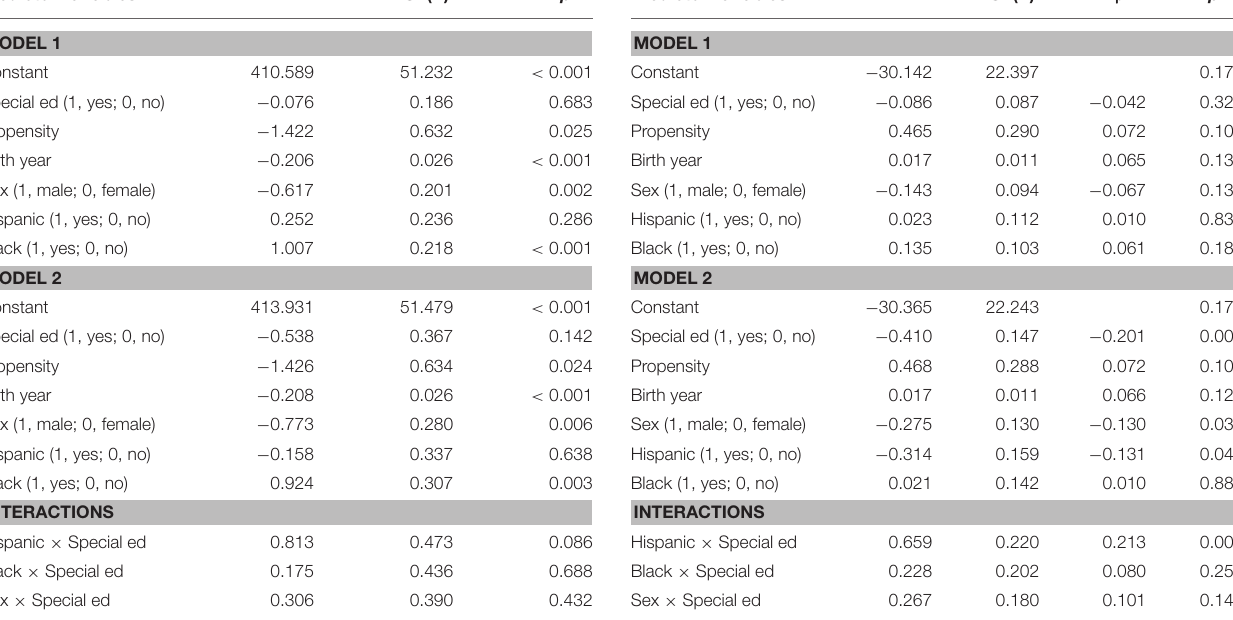
TABLE 9 | Hierarchical multiple regression analyses predicting physical health ( n = 586). Predictor